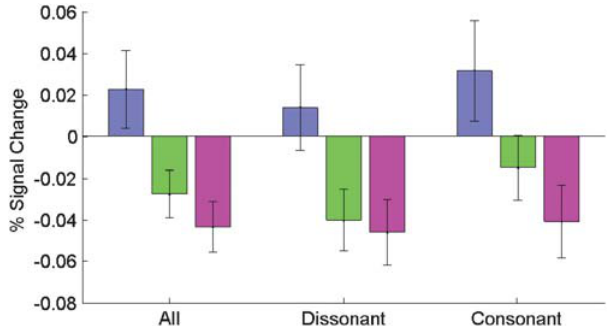
Figure 6. Response differences between amygdala subregions. We performed a region of interest (ROI) analysis to statistically evaluate response differences between the core regions (with 90–100% assignment probability) of the three amygdala subregions (see Material and Methods for further details). Bars in the above figure show the result of three averaging steps: first across all voxels of a given area, then either across all four music conditions, the dissonant conditions, or the consonant conditions, and finally across the 14 subjects. Results are given for left LB, SF, and CM in blue, green, and magenta. Error bars indicate the standard error of the mean from of the average across subjects. In each case, the differences between left LB and left SF and CM were significant at p , 0.005. There were no corresponding significant differences in the right amygdala.